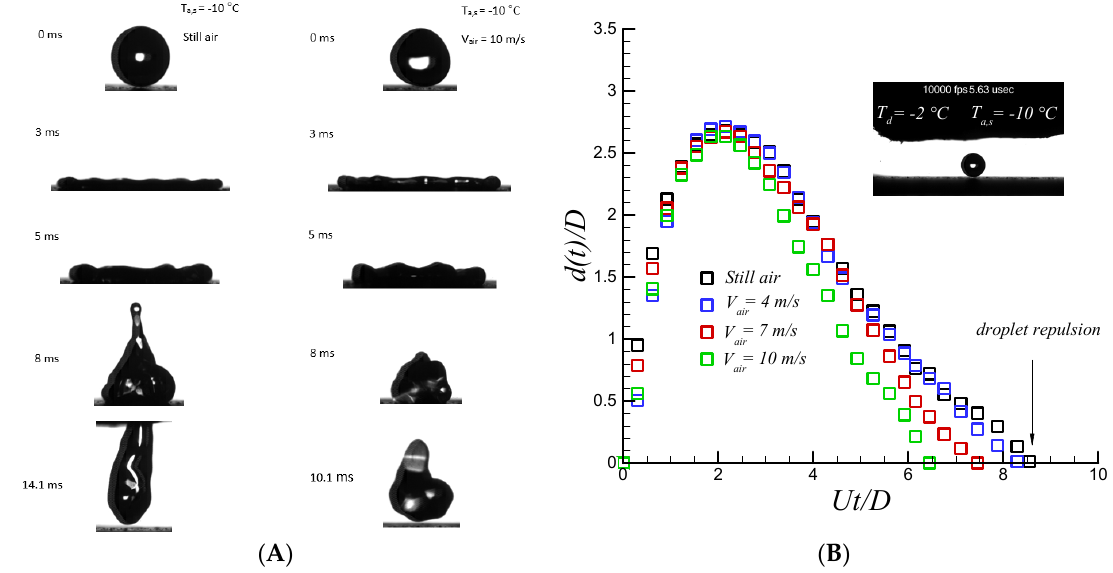
Figure 4. Sequential images of supercooled water droplet impacts on superhydrophobic substrate maintained at − 10 °C ( A ) along with analysis of temporal spreading diameter ( B ). Droplet size and impact velocity are 2.6 mm and 1.6 m/s, respectively.